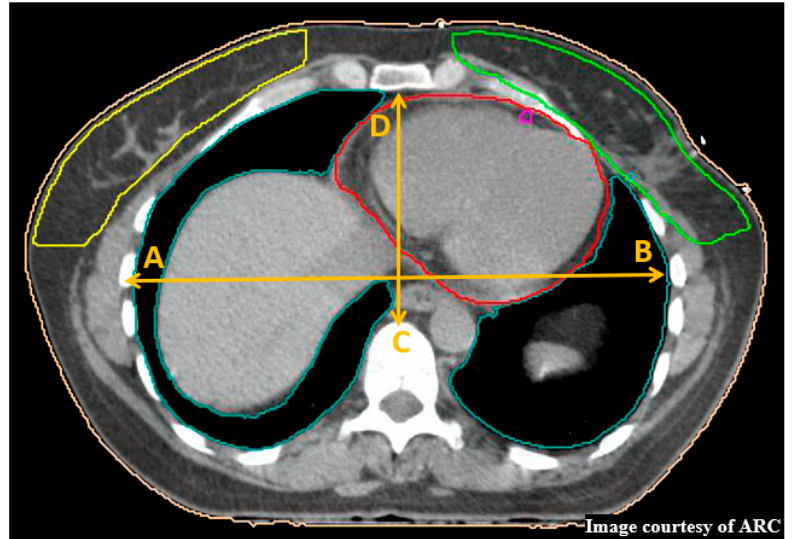
Figure 1. The Haller Index (HI) demonstrated on patient 17’s free breathing (FB) plan as the ratio between transverse diameter of the chest (length A → B) and the shortest distance between the sternum and vertebrae (length C → D) (Image Courtesy of ARC).